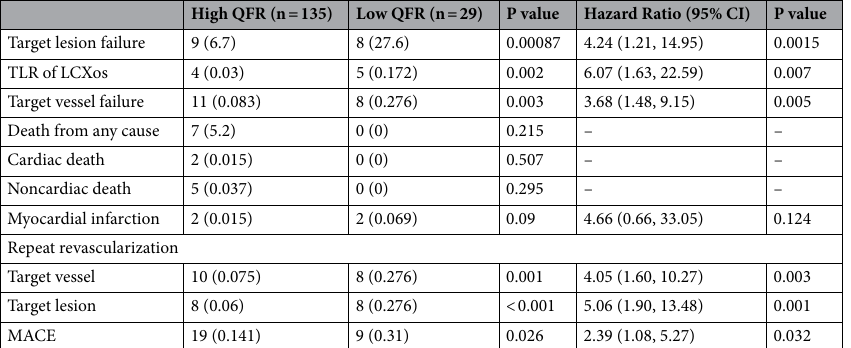
Table 4.. 5-Year clinical outcomes according to QFR of jailed